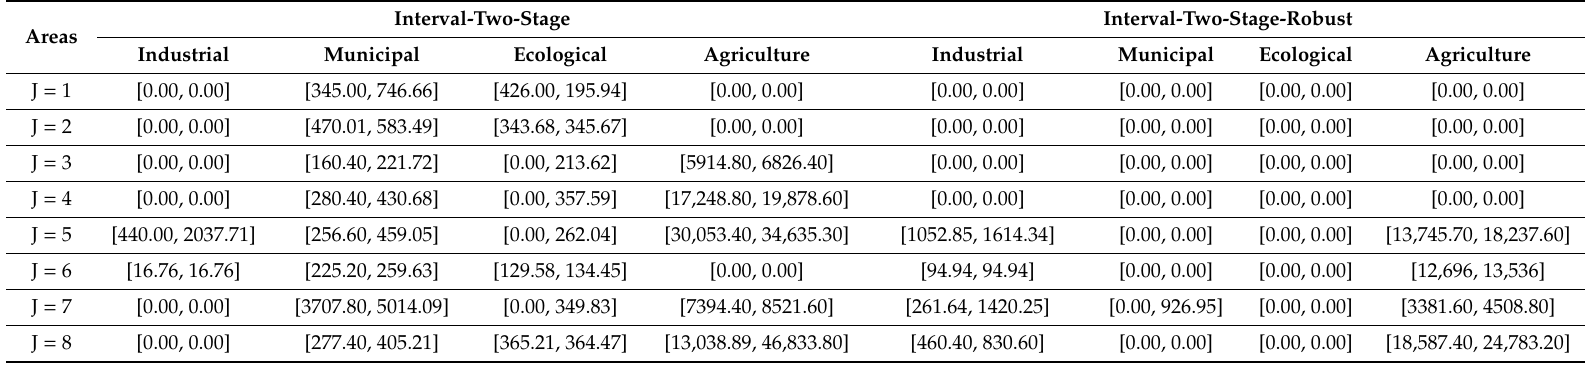
Table 7. Water shortage of ITSP model and ITSR model in di ff erent water use departments under low levels of available water resources in the first planning period (10 4 m 3 / year).